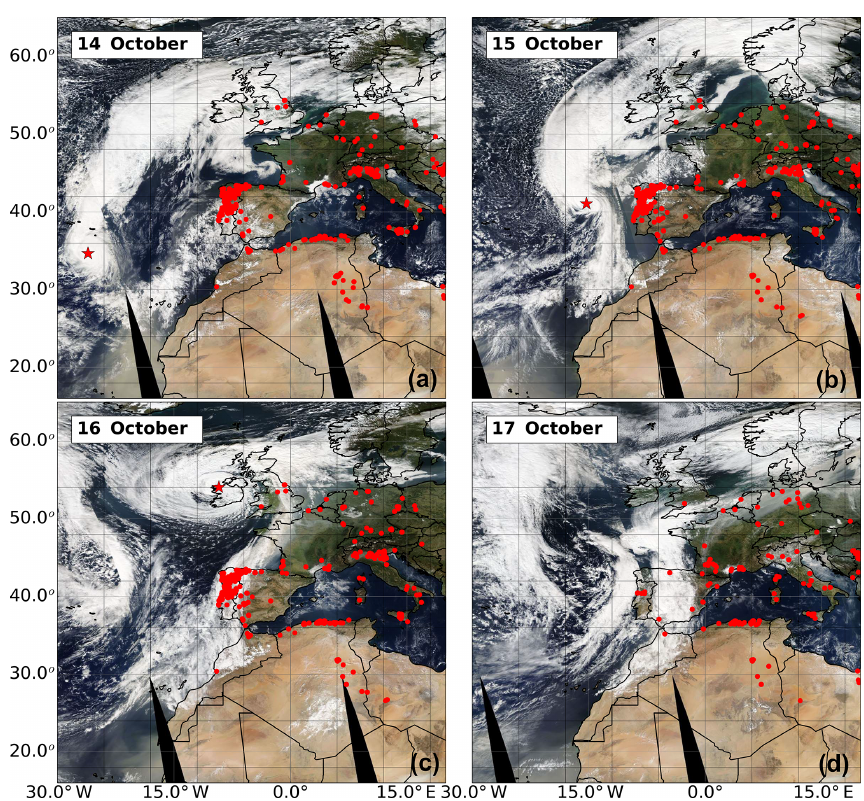
Figure 5. MODIS AQUA composite tiles for (a) 14, (b) 15, (c) 16, and (d) 17 October 2017. The MODIS temperature anomaly product is shown as red dots. The approximate overpass time for the central swath is 12:00UTC. Ex-hurricane Ophelia is highlighted with a red star in the panels (a) , (b) , and (c)